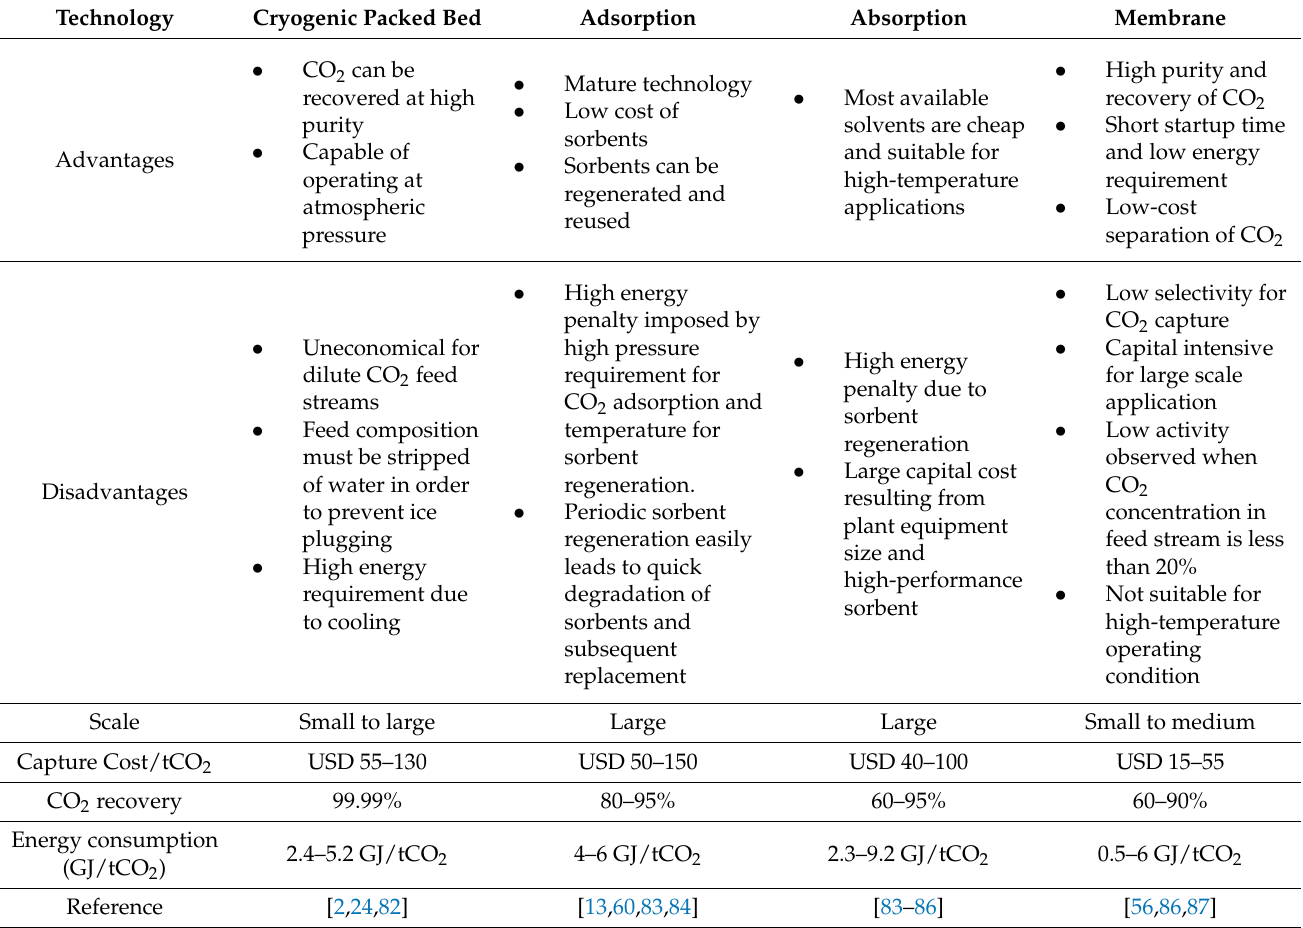
Table 3. Characteristics of cryogenic carbon capture relative to other carbon capture